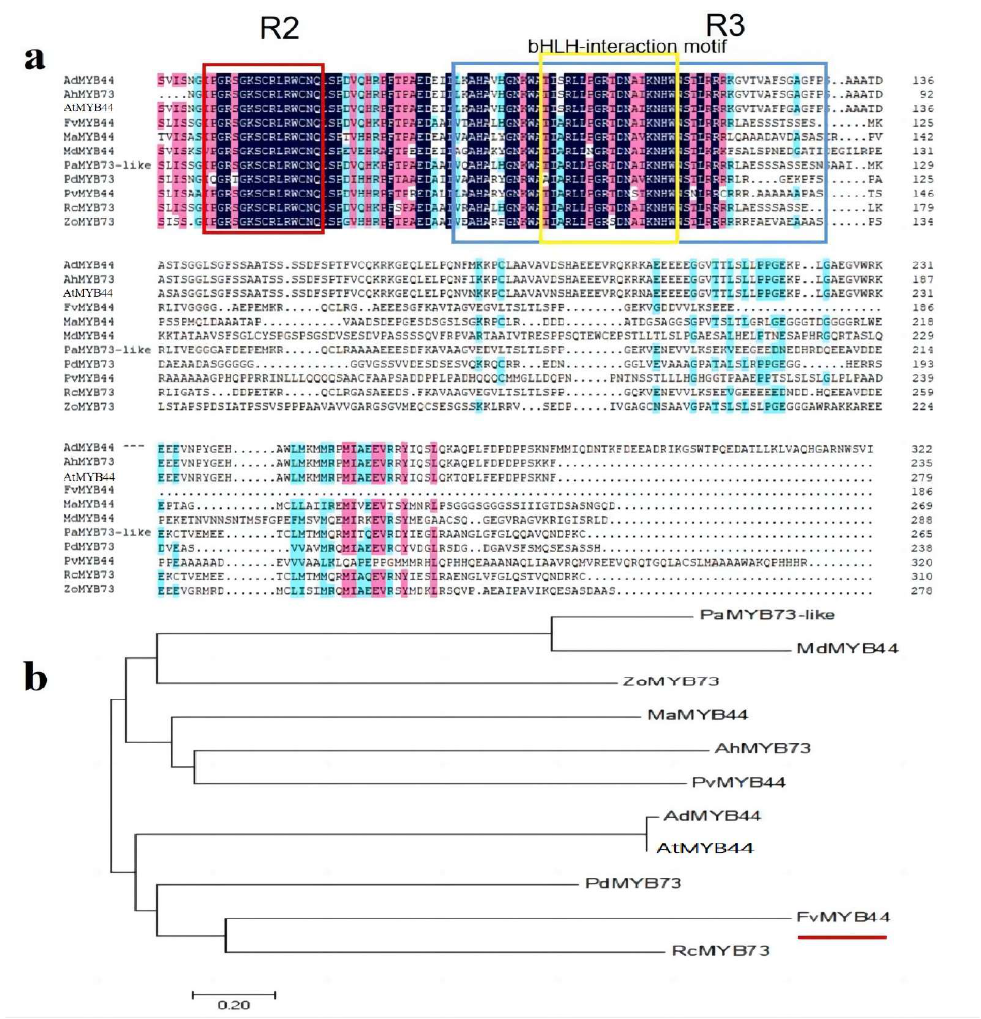
Figure 1. Contrast and evolutionary relationship between FvMYB44 and MYB transcription factors in different species. ( a ) Homology comparison among FvMYB44 protein and MYB protein in other plants. Red and yellow boxes mean the conserved regions of the MYB amino acid sequence. ( b ) MYB protein phylogenetic tree analysis in FvMYB44 and other plants, where FvMYB44 was underlined in red. The accession numbers are as follows: RcMYB73 ( Rosa chinensis , XP_024164121.2), PaMYB73-like ( Potentilla anserina , XP_050387456.1), PdMYB73-like ( Phoenix dactylifera , XP_008805112.1), ZoMYB73 ( Zingiber officinale , XP_042414516.1), AtMYB44 ( Arabidopsis thaliana , NP_201531), MaMYB44 ( Musa acuminata , XP_009400144.1), AhMYB44 ( Arachis hypogaea , XP_025609138.1), AdMYB44 ( Arachis